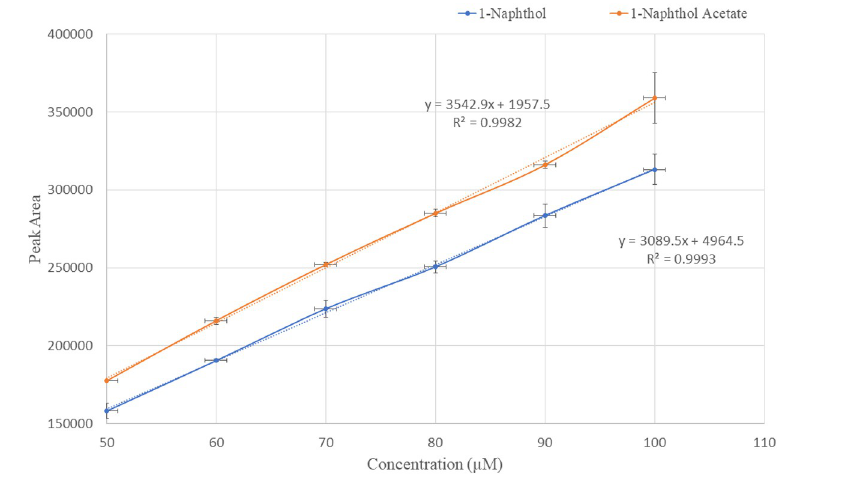
Fig 4. Regression analysis of linear concentrations of1-naphthol and 1-naphthol acetate.